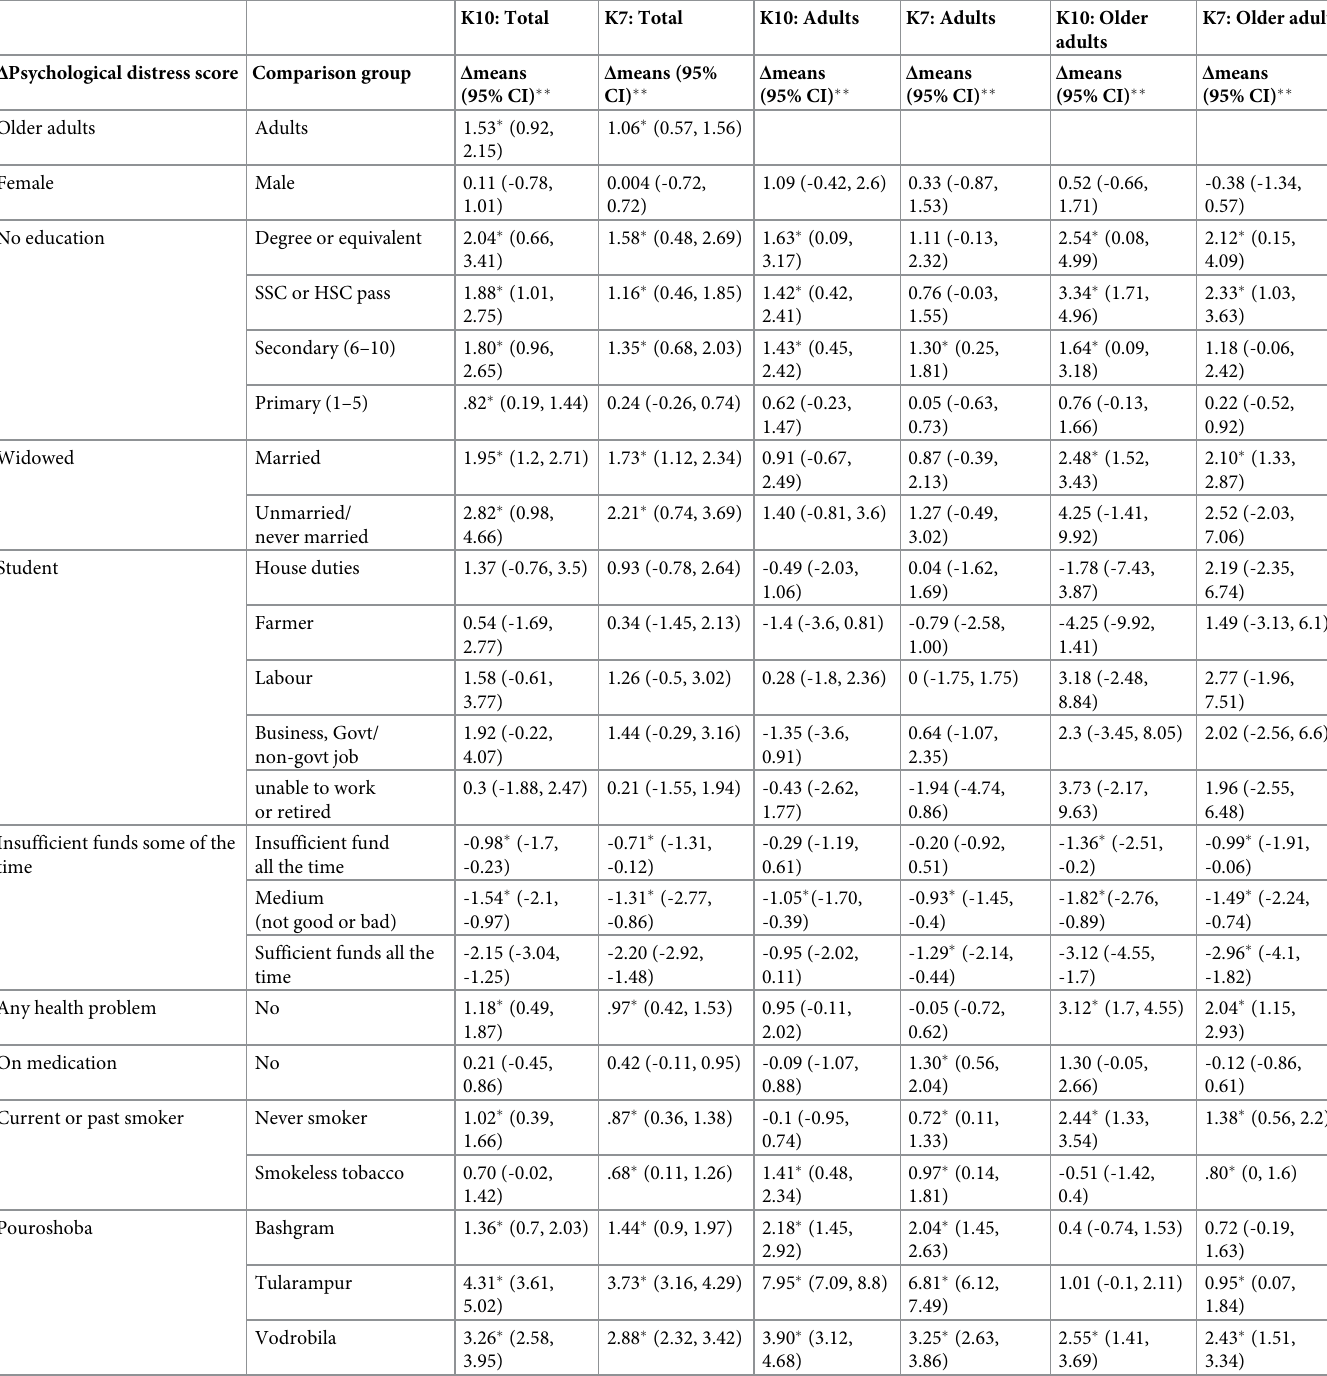
Table 6. Effect size (change in psychological distress score) in total sample, by adults and older adults for K10 and validated K7 scale. K10: Total K7: Total K10: Adults K7: Adults K10: Older